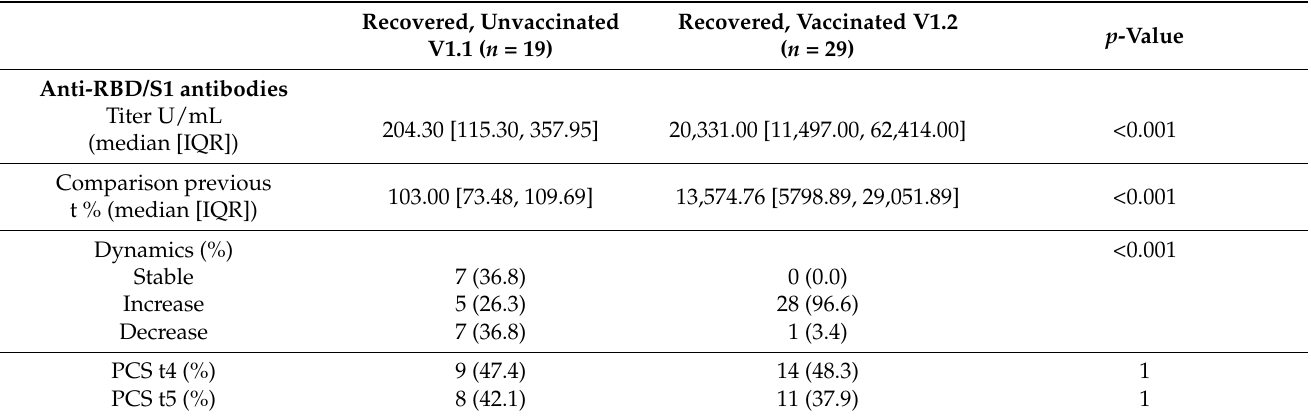
Table 3. Comparison of recovered unvaccinated (V1.1) and recovered vaccinated (V1.2) subjects at t5 (12-month appointment).